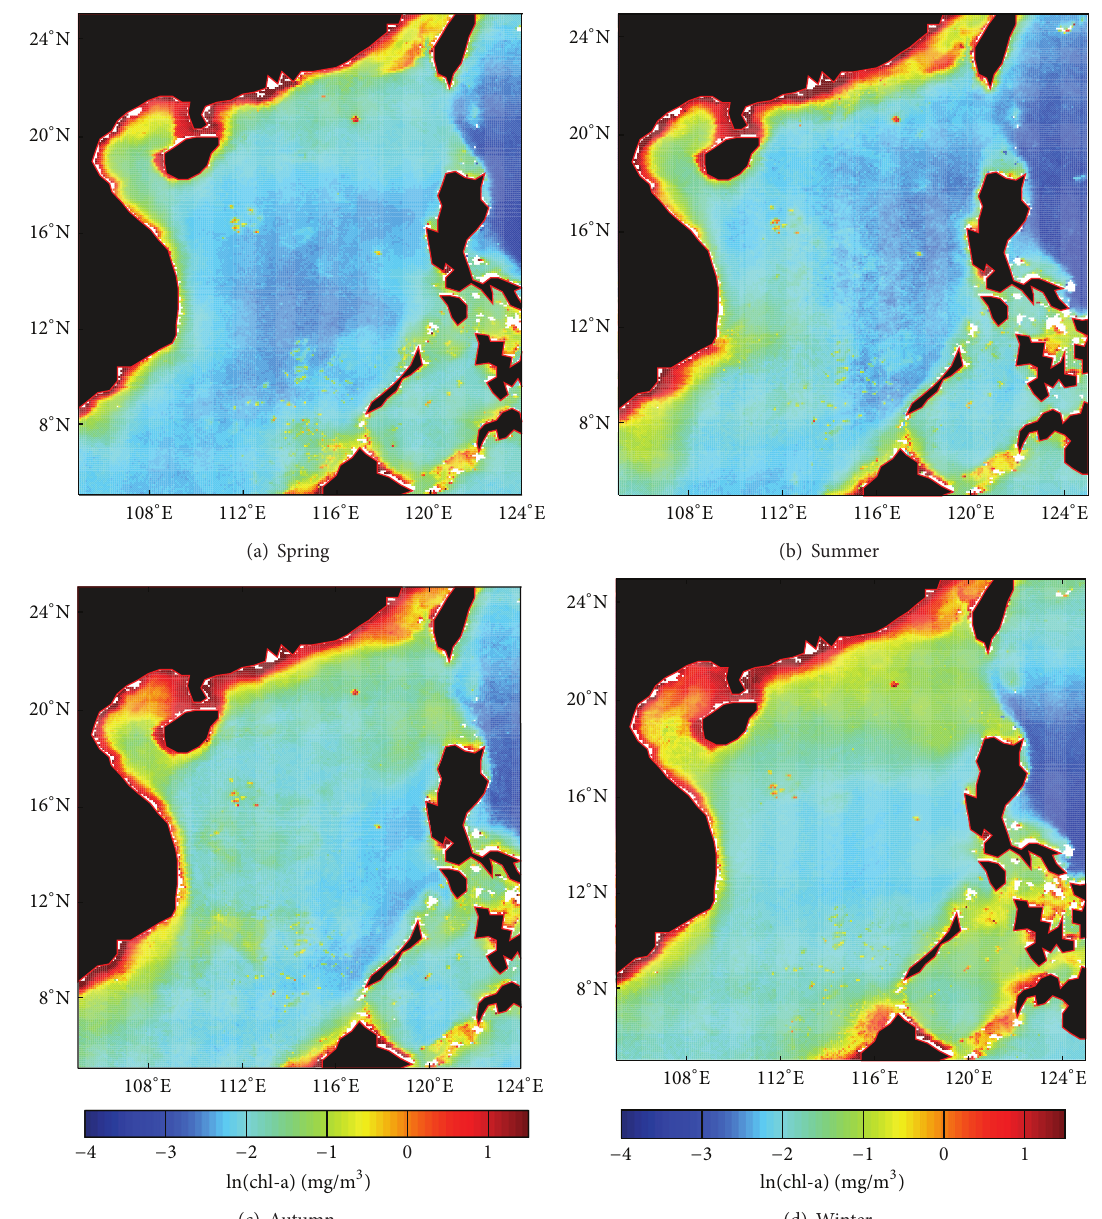
Figure 2: Seasonal average chl-a concentration from August 1997 to December 2009 in the South China Sea.